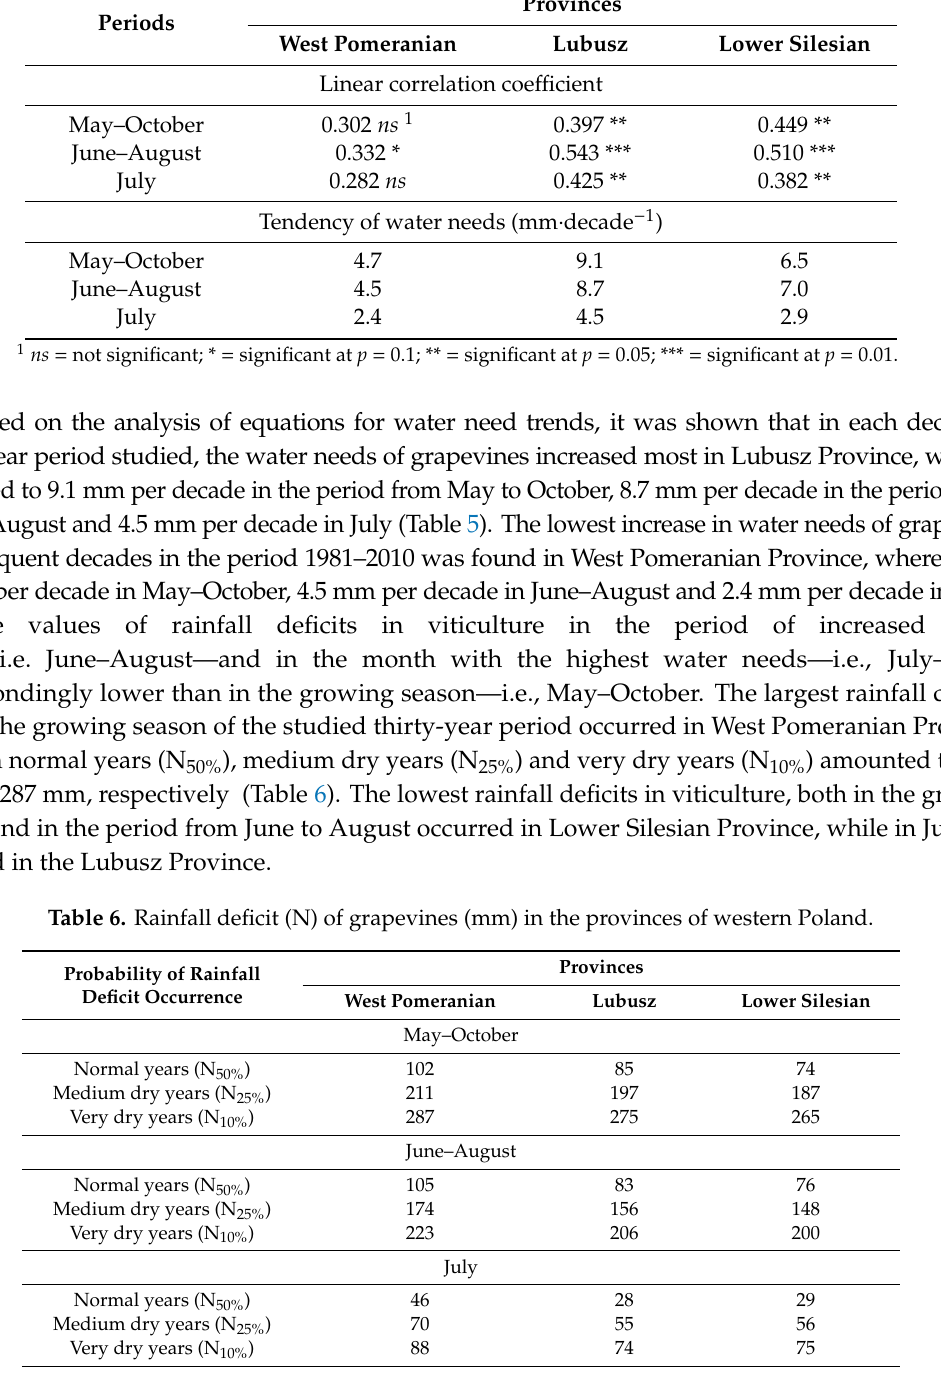
Table 5. Water needs (mm) of grapevines in the years 1981–2010 in the provinces of western Poland. Provinces Periods West Pomeranian Lubusz Lower Silesian